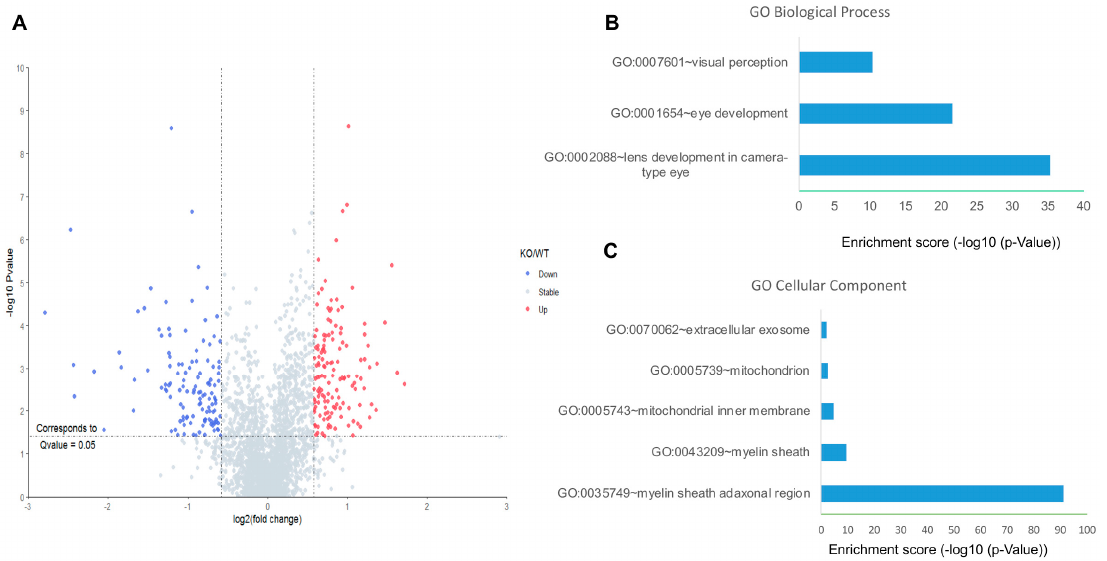
Figure 3. Proteomic analyses of the RPE/retina of WT and Kl -/- mice. ( A ) The volcano plot for the retina proteome in WT and Kl -/- mice. Blue color dots show down-regulated proteins, and red dots represent up-regulated proteins in Kl -/- compared to the WT retina; GO cellular component ( B ) and biological process ( C ) of down-regulated retina proteins in the RPE/retina of WT and Kl -/- mice (n = 5).